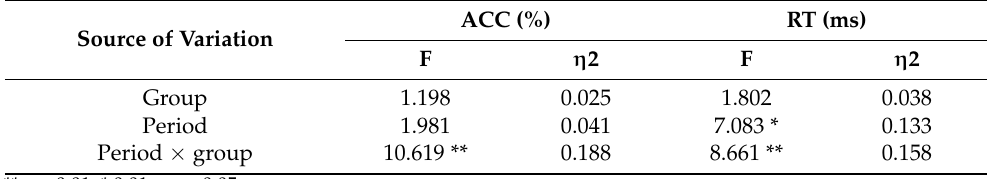
Table 2. Behavioral variance (ANOVA) analysis of the effect of orienteering exercises on the spatial memory ability of college students. (F in Table 2 represents the results of the ANOVA test, where the interaction between exercise intervention time and group repeated-measures ANOVA for correctness was significant, and the interaction between exercise intervention time and group repeated-measures ANOVA for response time was